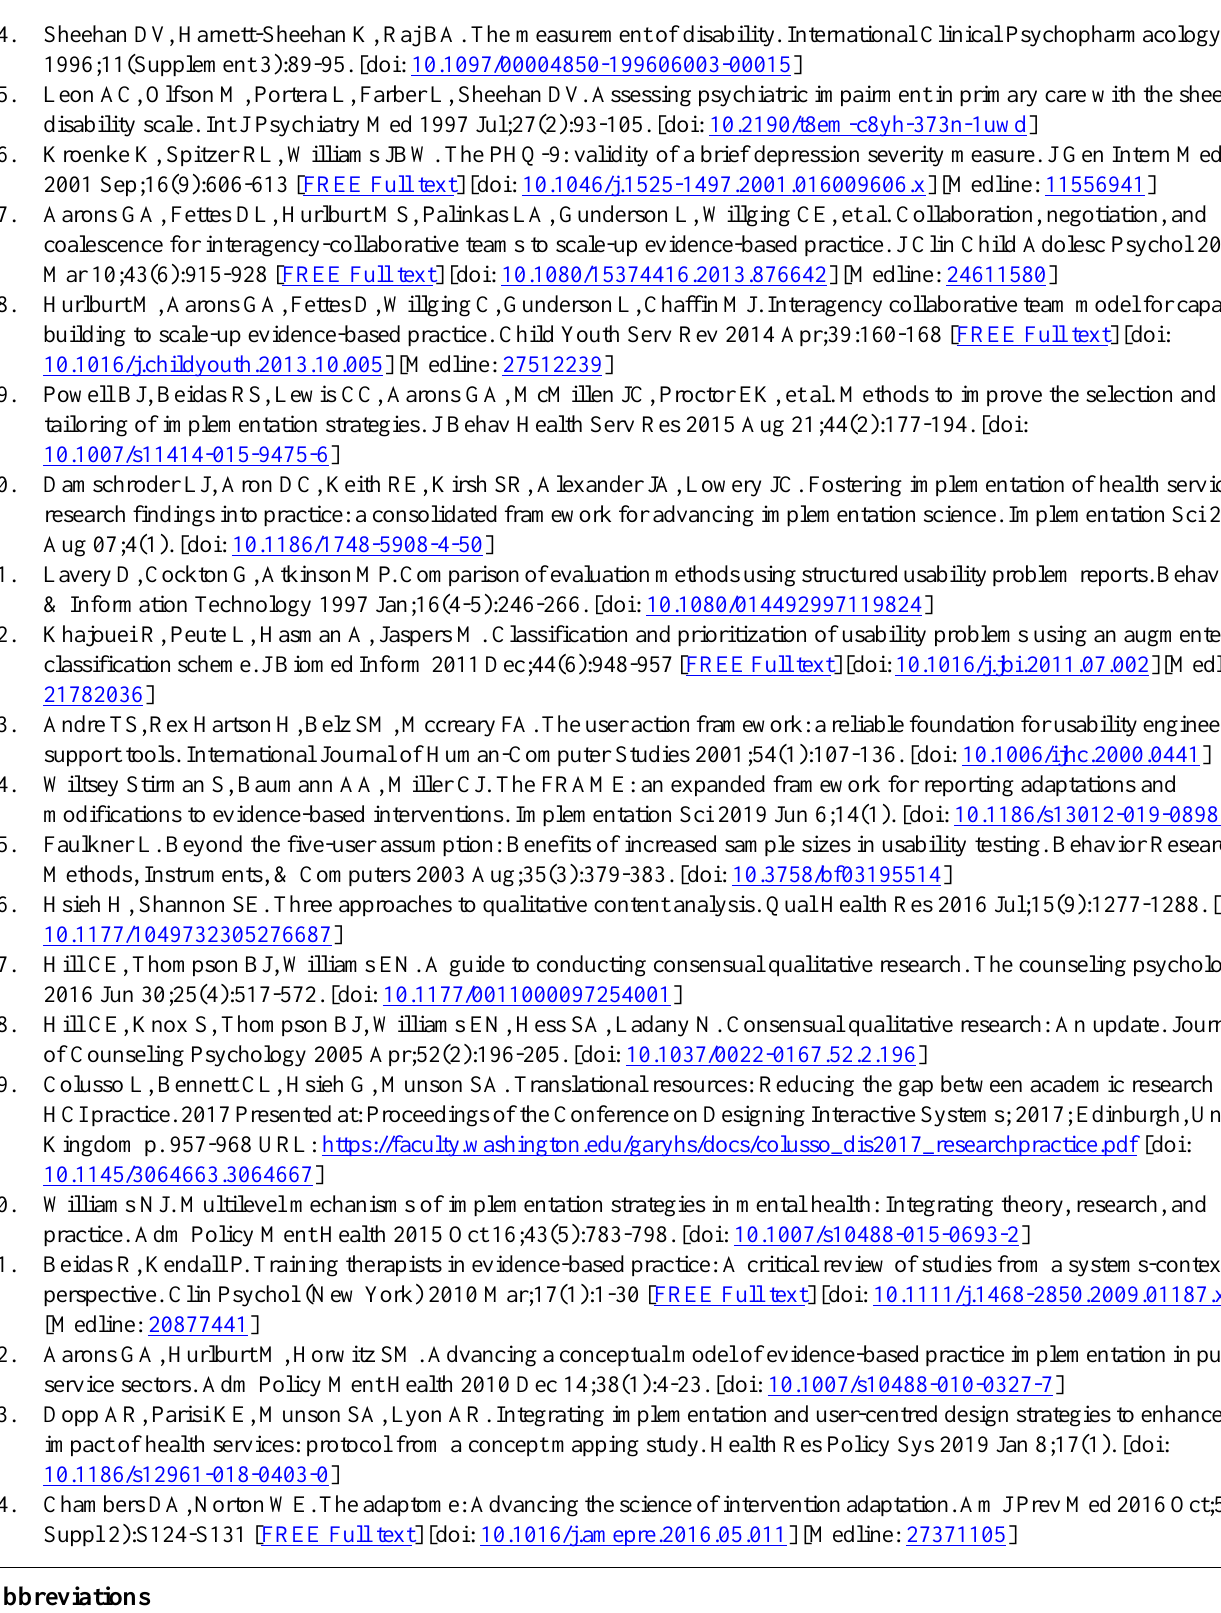
ALACRITY: Advanced Laboratories for Accelerating the Reach and Impact of Treatments for Youth and Adults with Mental Illness CFIR: Consolidated Framework for Implementation Research CPT: cognitive processing therapy DDBT: Discover, Design and Build, and